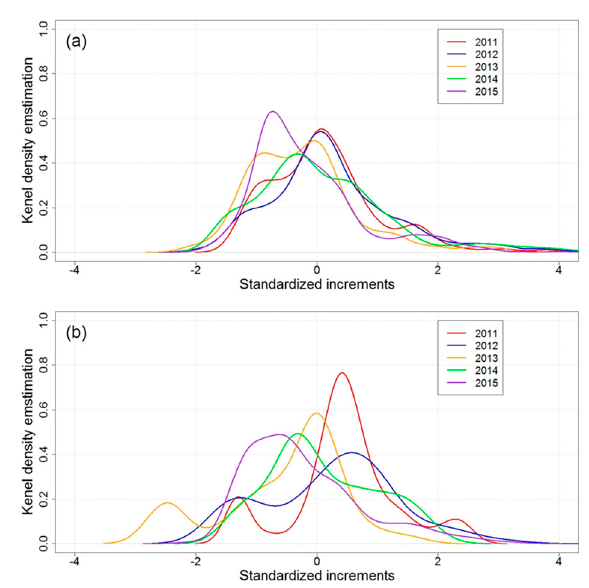
Figure 5. Kernel density estimation for standardized longitude increments at ( a ) 24 and ( b ) 120 h.